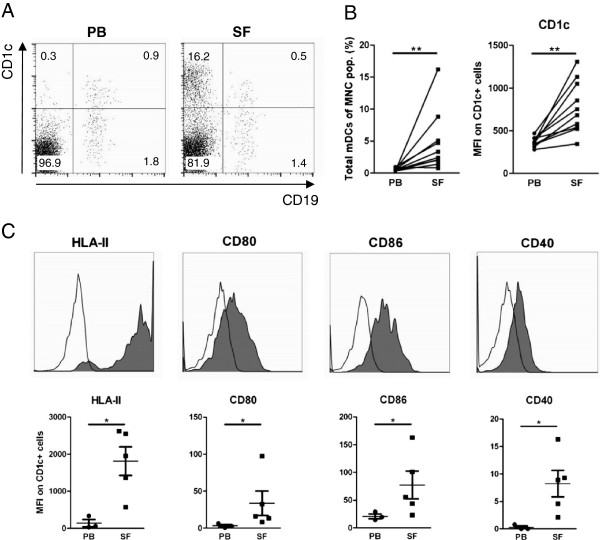
CD1c+ myeloid dendritic cells are abundantly present in joints of rheumatoid arthritis patients and express increased levels of antigen-presenting and costimulatory molecules. (A) Representative fluorescence-activated cell sorting (FACS) dot plot of CD1c-expressing myeloid dendritic cells (mDCs) and CD19+ cells in the peripheral blood (PB) and synovial fluid (SF) of a rheumatoid arthritis (RA) patient. (B) mDC numbers are increased in SF versus PB of RA patients (n = 10), and SF mDCs express higher CD1c levels. Percentages (%) of the total mononuclear cell (MNC) population and mean fluorescent intensity (MFI) of CD1c expression are given. (C) mDCs derived from SF (n = 5) express enhanced levels of antigen-presenting (human leukocyte antigen class II (HLA-II)) and costimulatory molecules (CD80, CD86 and CD40) as compared with PB-derived mDCs (n = 3). Representative histograms of isotype control (open) and HLA-II, CD80, CD86 and CD40 (filled) expression and mean are shown (MFI corrected for isotype fluorescence). Statistically significant differences of *P <0.05 and **P <0.01.